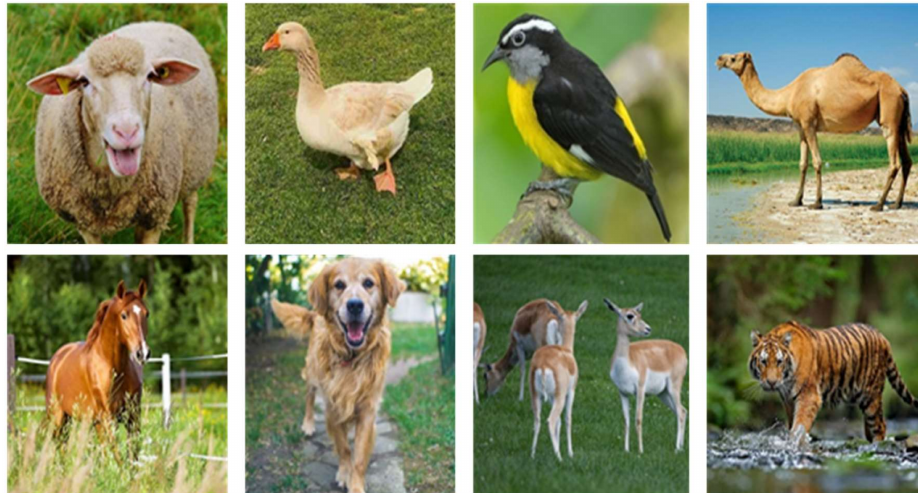
Figure 4. Samples from the large animal dataset (Dataset